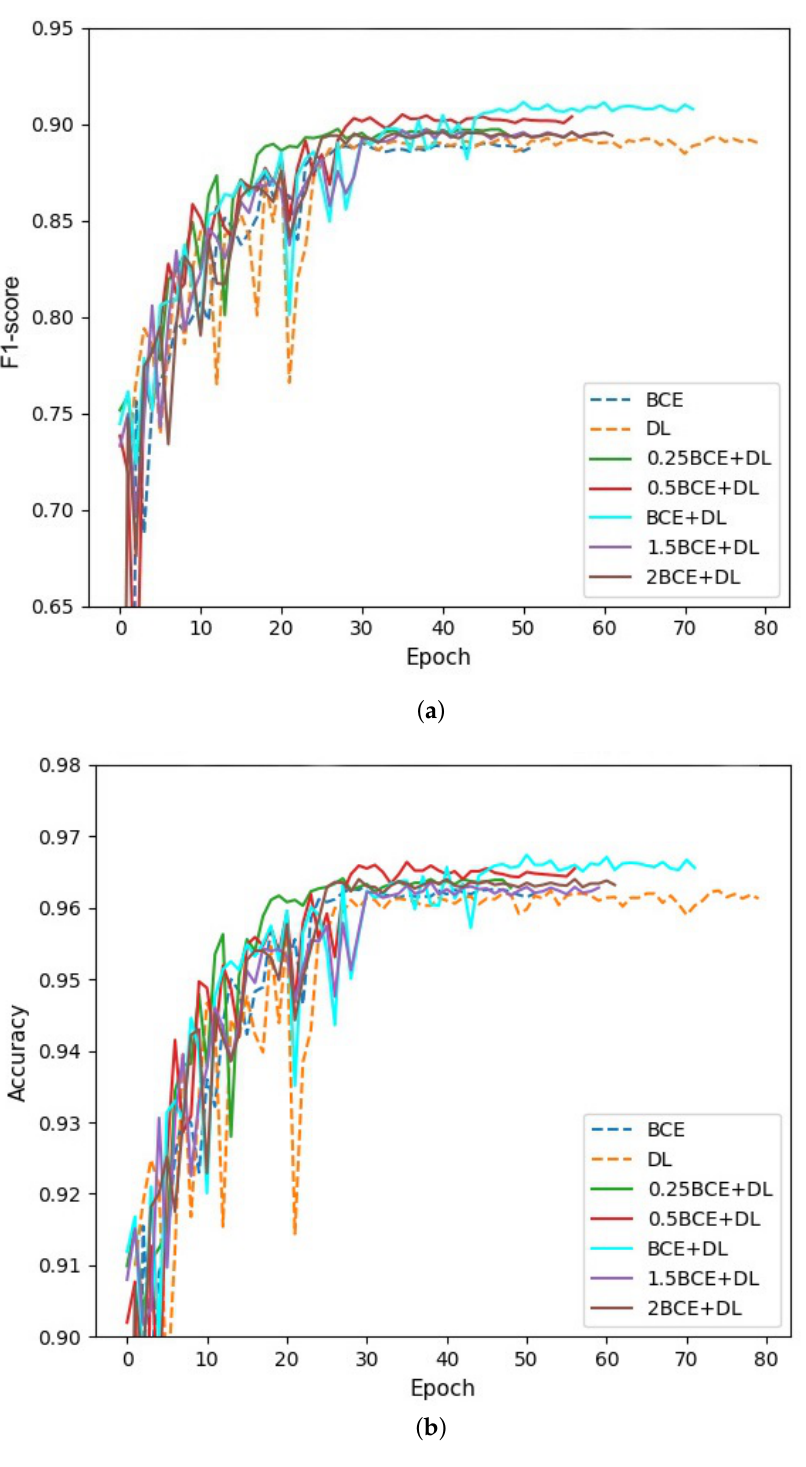
Figure 4. Validation performance for different coefficients of hybrid loss. ( a ) Validation F1-score for different coefficients of hybrid loss. ( b ) Validation Accuracy for different coefficients of hybrid